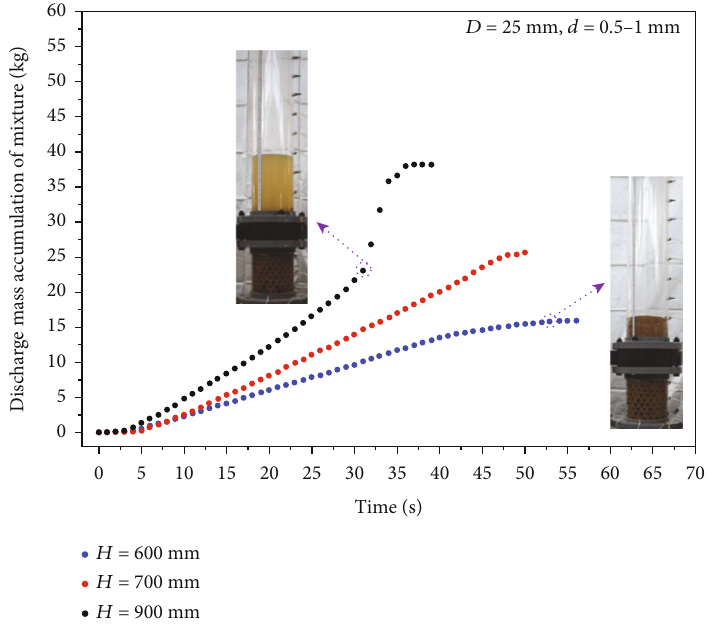
Figure 4: The cumulative curve of mass fl ow rate with